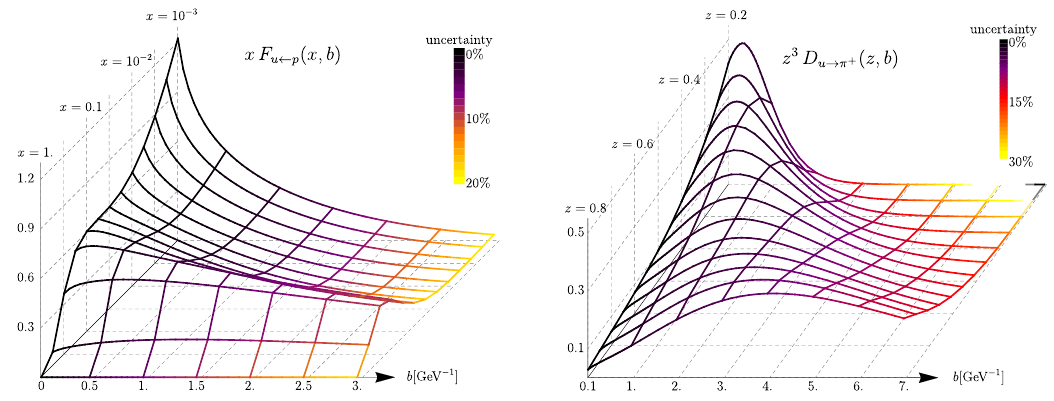
Figure 24 . Example of extracted (optimal) unpolarized TMD distributions. The color indicates the relative size of the uncertainty